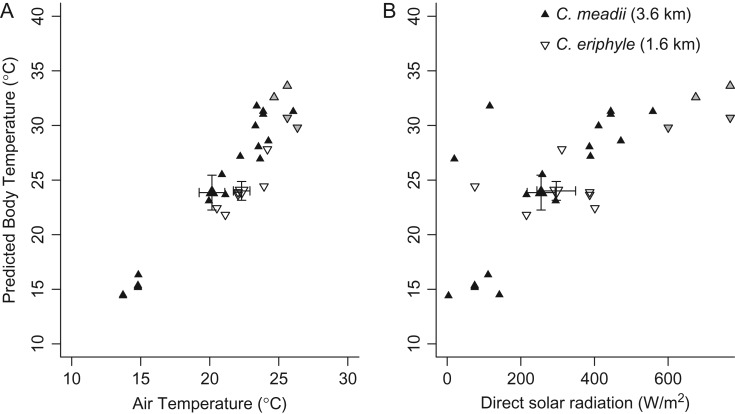
The predicted basking temperatures at flight initiation, taking into account that morphological differences for C. eriphyle (open symbols) and C. meadii (filled symbols) at Mesa Seco do not differ significantly between species on all days. The larger symbol depicts the mean ± SEM for both the air temperature (A) and solar radiation (B) and the predicted basking body temperature of individuals of each species.